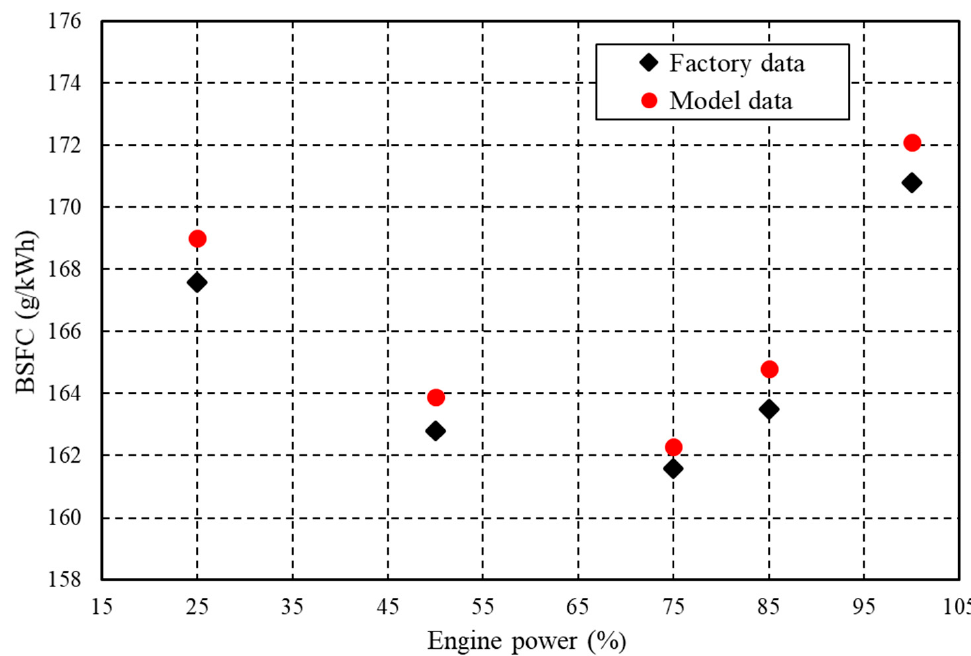
Figure 9. Specific fuel consumption of the WinGD RT-flex 58T-E diesel engine in the range from 25% Figure 9. Speci fi c fuel consumption of the WinGD RT- fl ex 58T-E diesel engine in the range from 25% to 100% MCR. to 100% MCR.